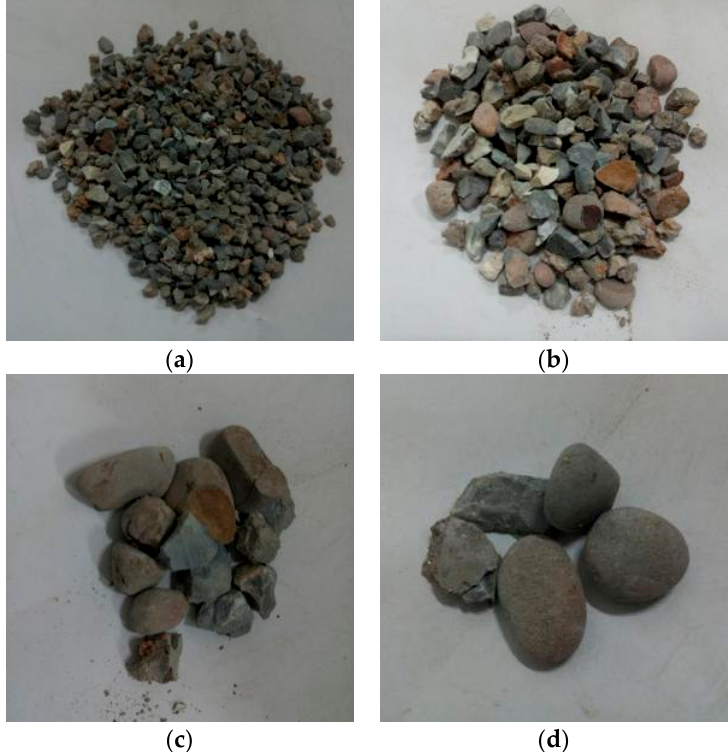
Figure 8. Concrete particles after slow heating up to 800 °C and sieving (impact speed 8.6 m/s), water cooling. ( a ) 5 mm (51.97%); ( b ) 10 mm (26.44%); ( c ) 16 mm (8.2%); ( d ) 20 mm (13.29%).